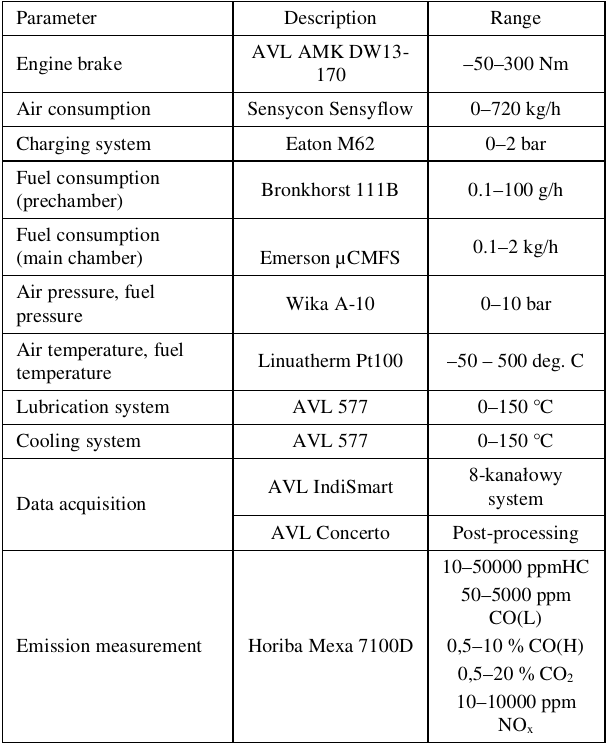
Table 3. Measuring equipment of the researched engine AVL 5804